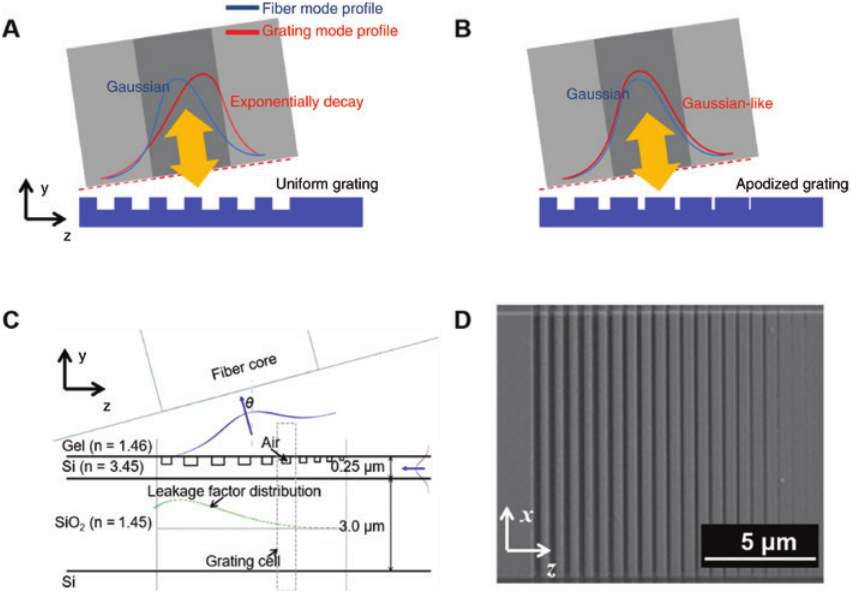
Figure 10: Diffraction grating-based optical coupling with apodized grating. Schematic diagram of mode overlap difference between (A) the uniform and (B) apodized gratings. Depending on the grating apodization, ′ ) are propagated from waveguide 1 (grating-based optical exponentially decaying or Gaussian-like electric field profiles (red curves, E 1 couplers) and Gaussian modes (blue curves, ∑ E ) are the guided modes in waveguide 2 (optical fibers). (C, D) Cross-section and SEM image 2, k for the apodized grating couplers based on optimized fill factors. Adapted from Ref. [109]. Copyright (2013) The Optical